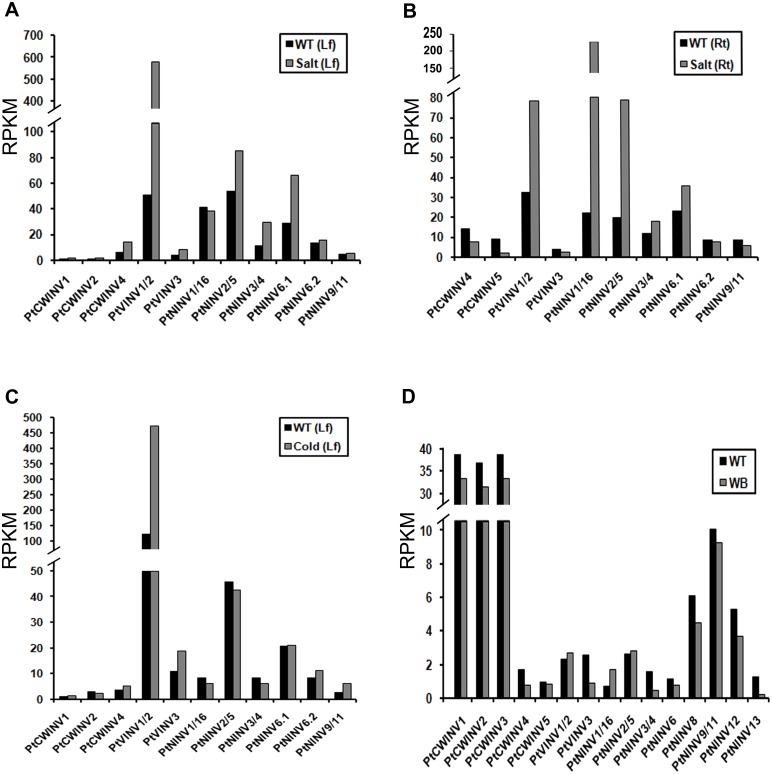
Expression profiles of PtINV gene members in response to salt/cold stress conditions (A-C) and pathogen infection (D).WT, wild type; WB, with Botryosphaeria infection; Lf, leaves; Rt, Roots.